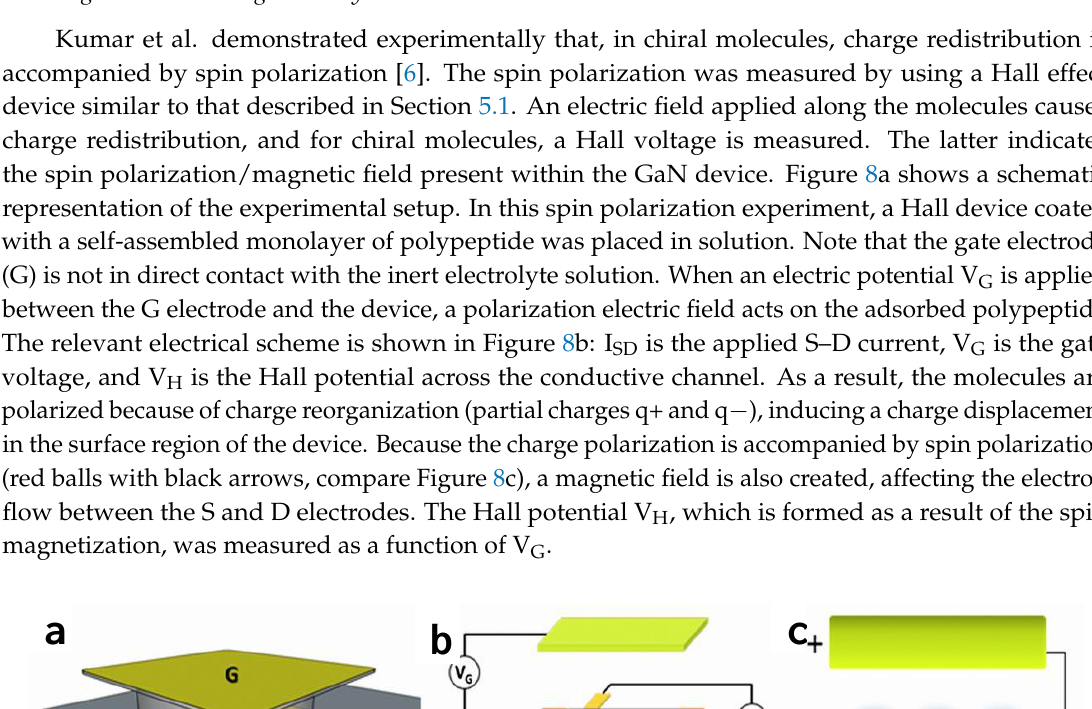
Figure 9. Hall measurements conducted on devices coated with different oligopeptides. ( a )